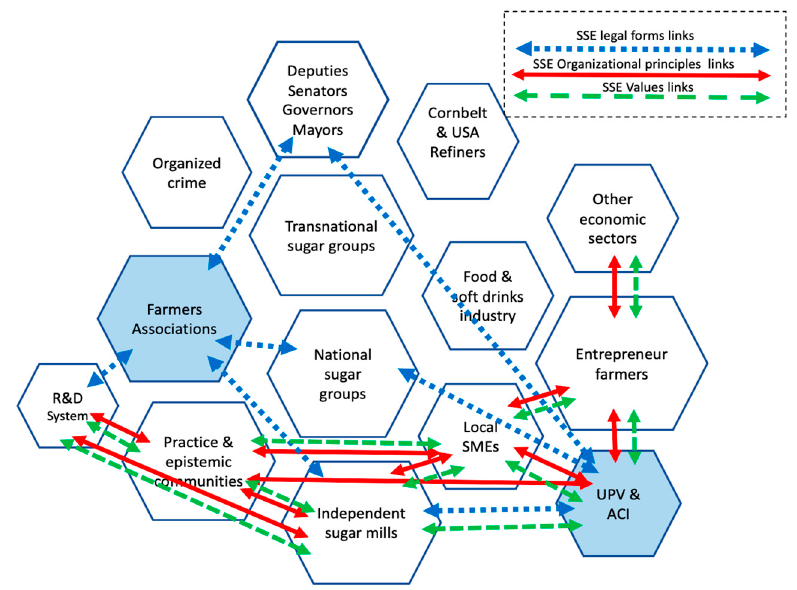
Figure 2. Links of meso rules diffusion through the different mechanisms: the expanded scope of the SEE entities. Source: Own made.